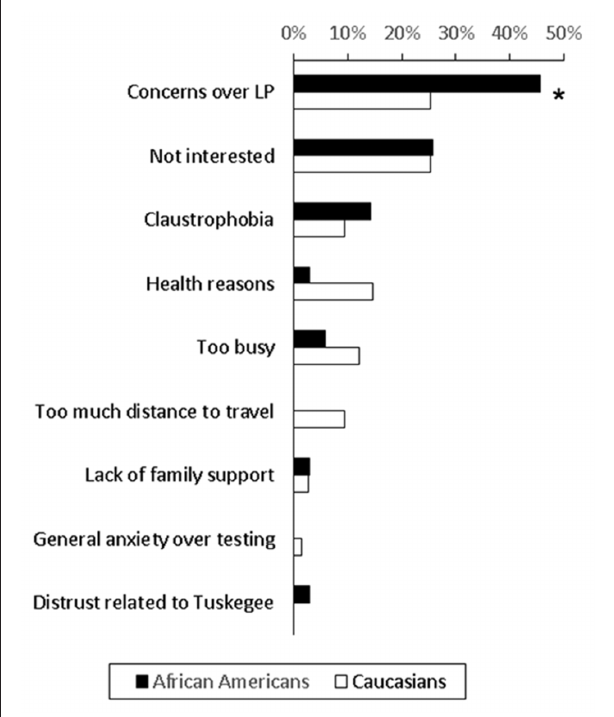
FIGURE 1 | Reasons for non-participation among African Americans and Caucasians who declined to undergo a biomarker study involving lumbar puncture (LP) and MRI. 59% of African Americans and 87% of Caucasians who did not participate in the biomarker study provided the main reason for non-participation, and these reasons are shown as percentage of all reasons ( ∗ p =